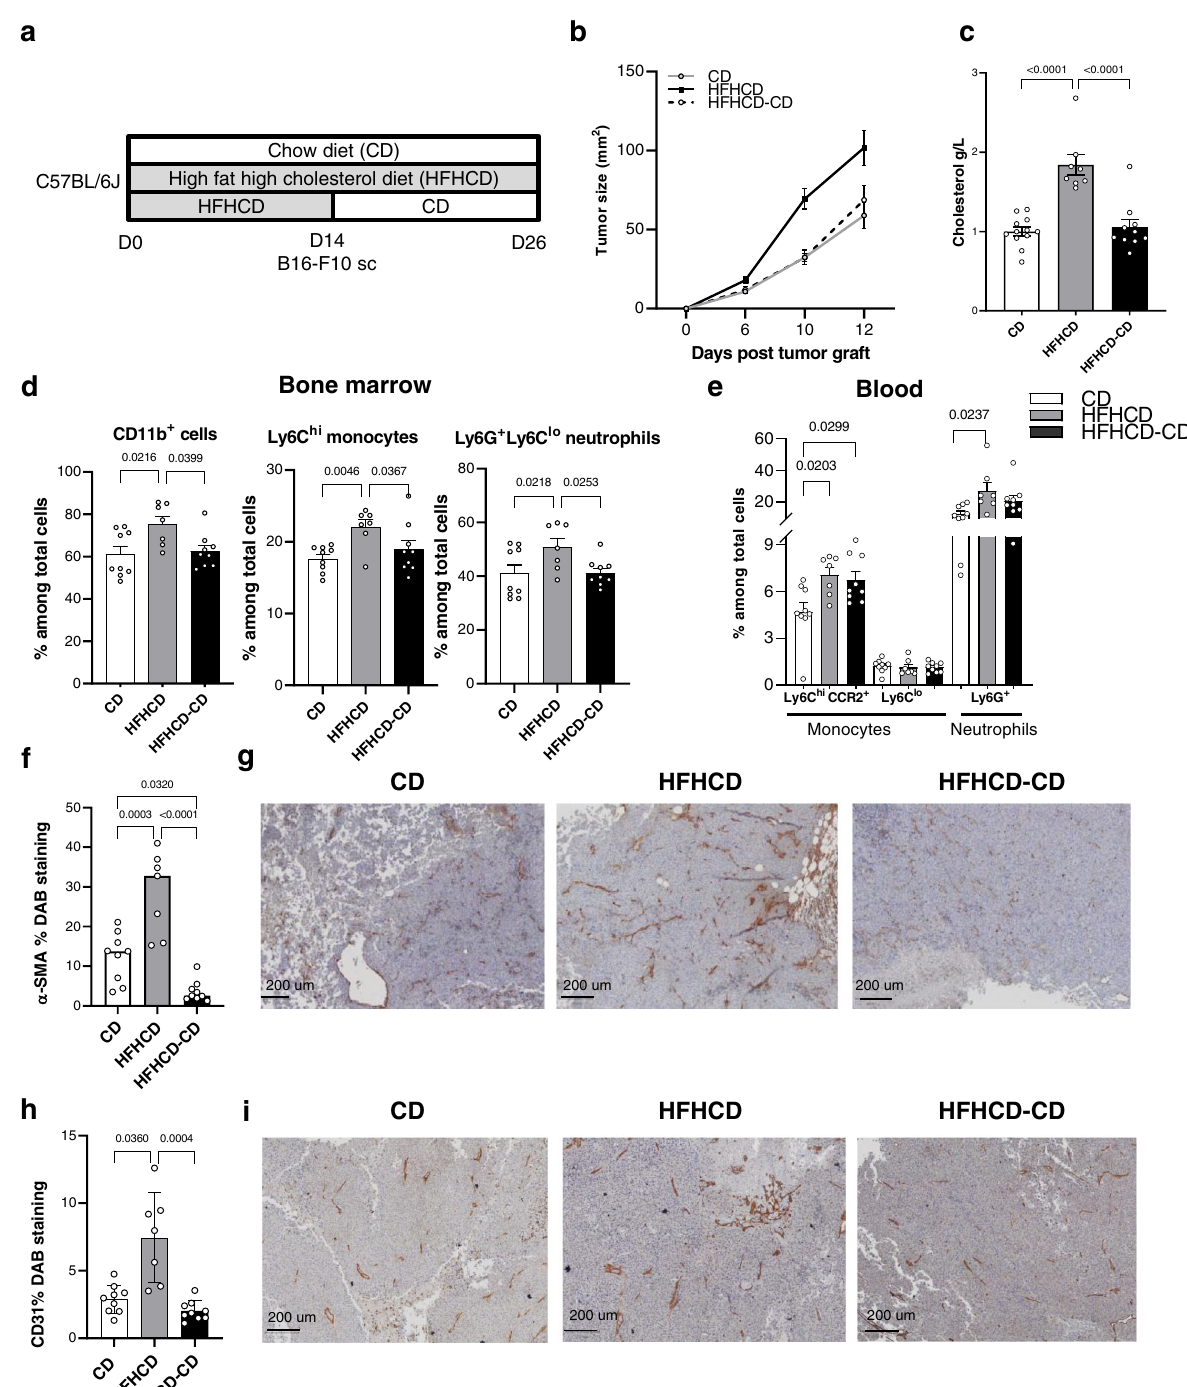
Fig. 6 | Switching diet avoid the effect of HFHCD on tumor growth. C57BL/6J mice were fed for 2 weeks with CD or HFHCD, part of HFHCD – fed mice was switched to CD the day of tumor graft. Mice were transplanted with 0,25×10 6 B16-F10cells (s.c.)and sacri fi ced atday12postinjection. a Experimentaldesign. b Tumor size evolution over time (at day 10 p =0.0003 CD versus HFHCD and p =0.002 HFHCD-CD versus HFHCD; at day 12 p =0.014 CD versus HFHCD and p =0.010 HFHCD-CD versus HFHCD). c Plasmatic cholesterol concentration ( n =12 in CD group, n =8 in HFHCD group, n =10 in HFHCD-CD group). d Flow cytometry analysis of (%) CD11b + myeloid cells, Ly6C hi monocytes and Ly6G +